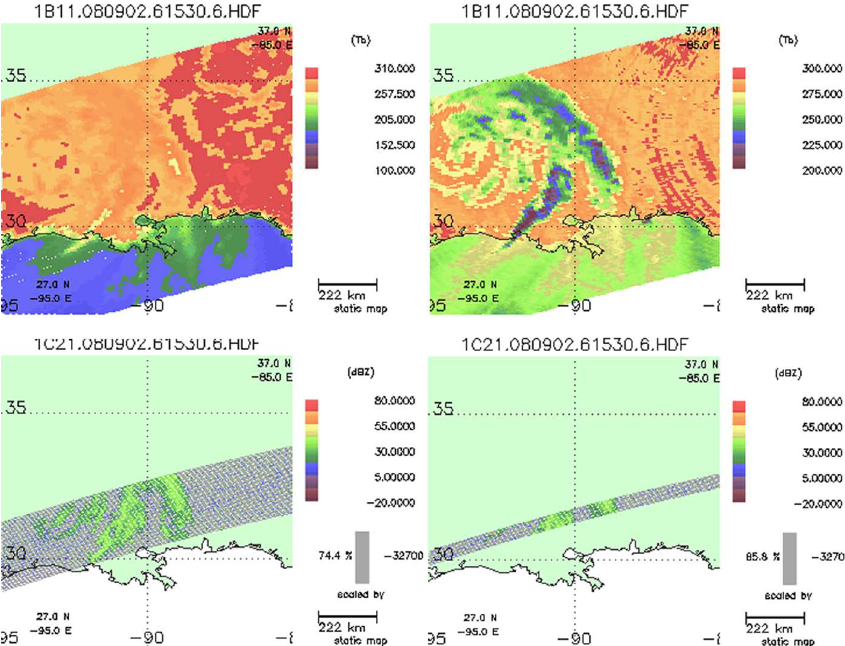
Fig. 2. TRMM observations over the selected case study of Louisiana and Mississippi, 2 September 2008 at 15:30UTC. Top pan- els: TRMM 1B11 brightness temperature (TB) product relative to TMI channel 7 (37GHz horizontal polarization, left), beam effective field-of-view (EFOV) of 16 × 9km 2 , and TMI channel 9 (85.5GHz horizontal polarization, right) with a main-beam EFOV of 7 × 5km 2 . The cyclonic cell indicated in Fig. 1 is near-fully imaged. Bottom panels: the TRMM 1C21 radar reflectivity (dBZ) product, relative to PR normal sample (left) range bin 75, and PR rain oversample (right), range bin 16. Note that the PR swath is 220km wide (reduced in the over- sampled product) and the range resolution is 0.25km; TMI swath is 760km wide. This image has been realized by using NASA/GSFC PPS Orbit